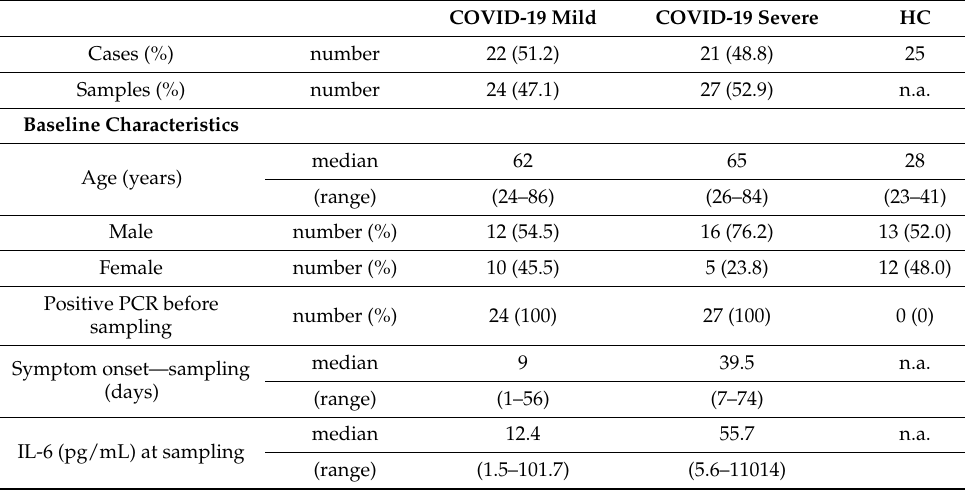
Table 1. Characteristics of coronavirus disease 2019 (COVID-19) patients and healthy controls